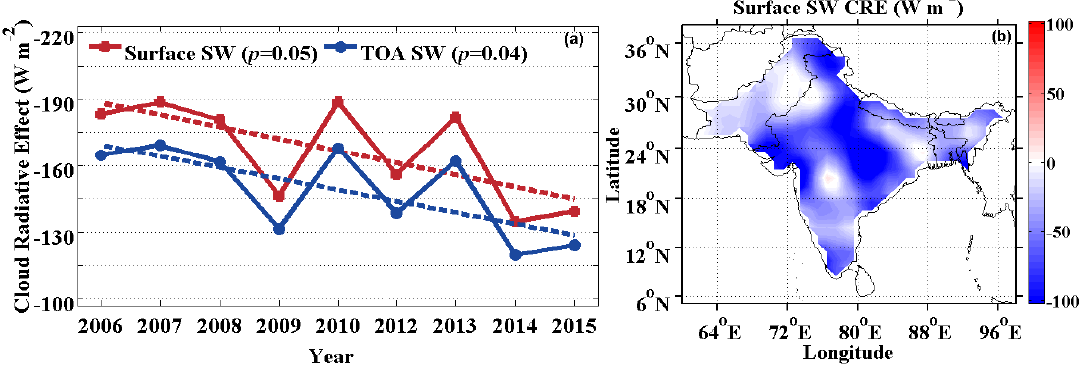
Figure 5. ( a ) Temporal variations in spatial average CRE at the TOA and surface, and ( b ) spatial distribution of the temporal changes in average SW CRE from CloudSat at the surface during the monsoon season in South Asia from 2006 to 2015. The dashed lines indicate the linear fit line of the solid line with the same color; p is the significance level.